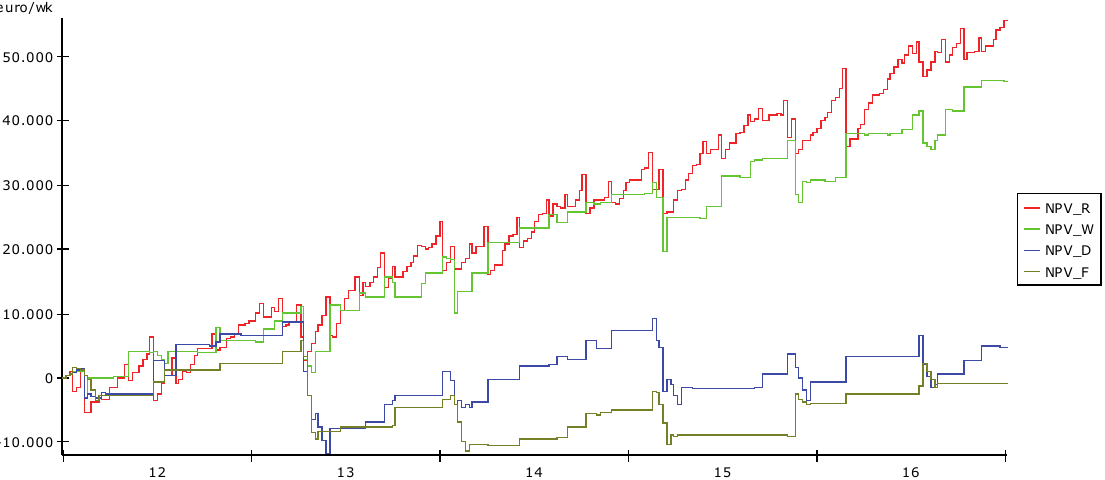
Fig. 6. Reporting about Annuity Stream under coordination based on VMI